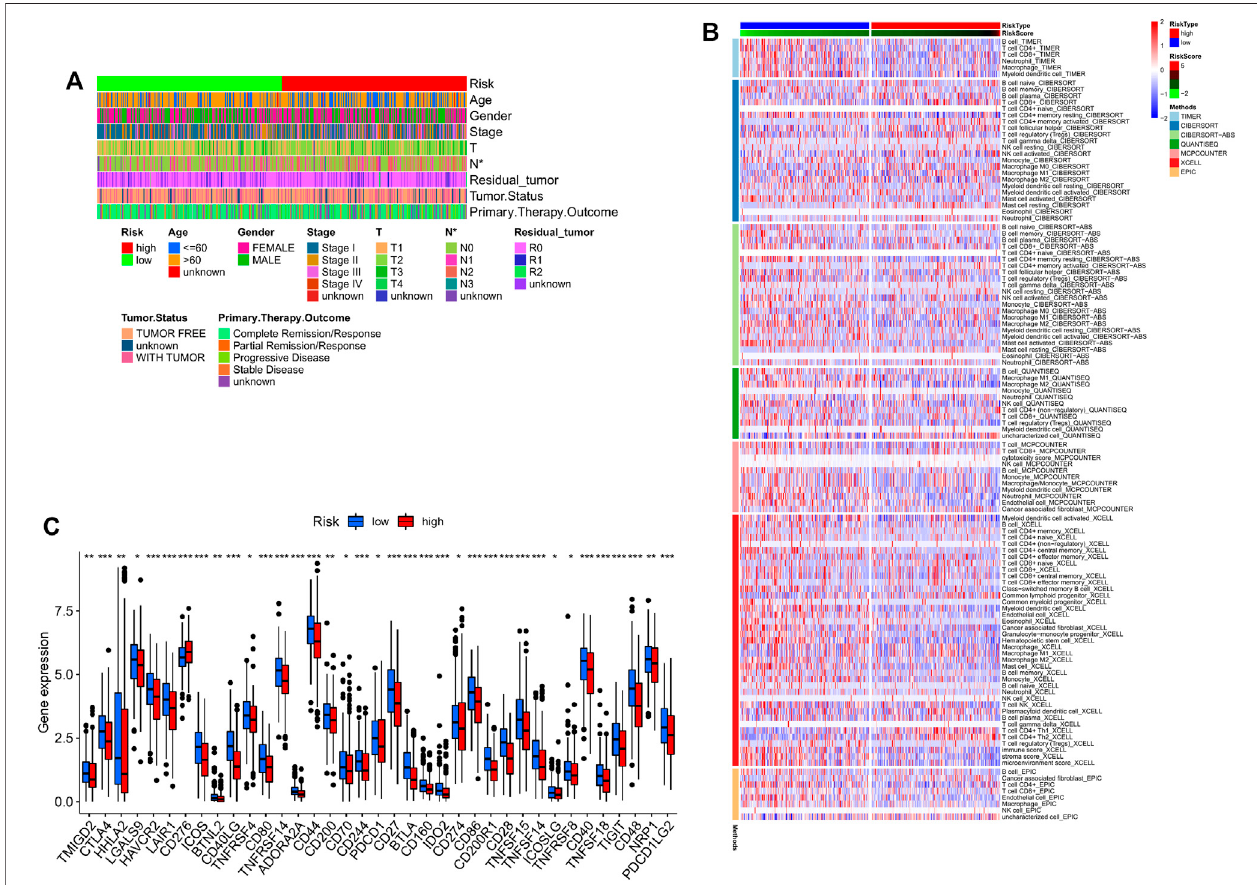
FIGURE 5 | (A) Clinical phenotypes of patients in the two risk groups. (B) Immune in fi ltration in the high- and low-risk groups. (C) Immune checkpoint expression levels in the two risk score groups.